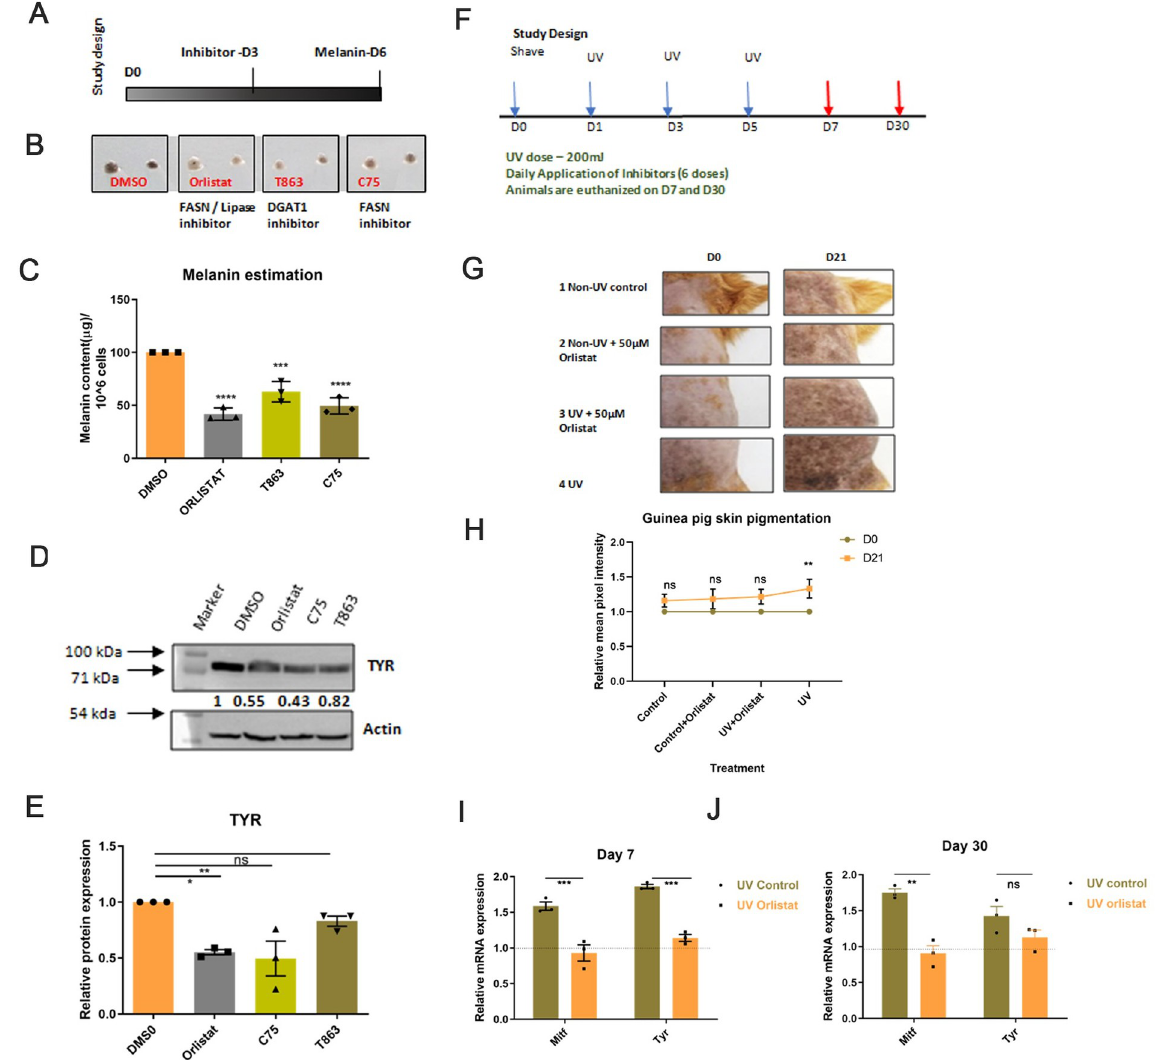
Fig 7. Fatty acid metabolism is a critical pathway in mediating pigment production. (A) Schematic showing experimental timeline for inhibitor addition and analysis of pigmentation in B16 cells. ( B) Representative image showing phenotypic differences in melanin accumulation upon inhibitors treatment in 2 technical replicates of D6 cells. Two technical replicates are taken for 3 independent biological sets. ( C) Bar graph depicting melanin estimation after different inhibitor treatments. Mean ± SEM is plotted for 3 biological replicates. One-way ANOVA is applied, F(3,8) = 43.13. p -Value < 0.0001. Dunnett’s test for pairwise. ( D) Representative western blot for TYR expression, wrt to Actin, on D6 upon Orlistat, C75 and T863 treatment. Numerical values show average fold change for 3 biological replicates. ( E) Bar graph depicting quantitative analysis of tyrosinase expression upon Orlistat, C75, and T863 treatment with respect to Actin. Fold change is calculated relative to DMSO. Mean ± SEM is plotted for 3 independent replicates. One-way ANOVA is applied, F(3,8) = 8.438, p -value = 0.0074.Dunnett’s multiple comparison test is performed for pairwise analysis. ��� p -Value < 0.005, �� p -value < 0.01, � p -value < 0.05. ns is not significant. ( F) Experimental timeline showing UV-mediated pigmentation induction in guinea pigs. Three doses of UVA+B were given on days 1, 3, and 5 (shown by the blue arrow). Six doses of inhibitor were applied for the first 6 days. Animals were euthanized on D7and D30 (shown by the red arrow). ( G) Representative photographs showing phenotypic differences in guinea pig skin pigmentation on D0 and D21. Four segments were marked based on different treatments and are followed temporally on the same animals in the groups of 3. Arrows represent the region showing maximum changes. ( H) Line plot showing fold change of mean pixel intensity of images on D21 normalized to D0. Fold change was calculated by comparing each segment across days on the same animal. Mean ± SEM is plotted for 3 independent biological replicates. Two-way ANOVA is applied. Sidak’s multiple comparison test is performed for pairwise analysis. p -Value for Control D0–D21 = 0.1882, p -value for Control + Orlistat D0–D21 = 0.1104, p -value for UV + Orlistat D0–D21 = 0.0554, p -value for Control D0–D21 = 0.0055. ( I) Bar graph depicting qRT-PCR-based analysis of Mitf and Tyr expression from epidermal cells on day 7. Mean ± SEM is plotted for 3 individual guinea pigs. One- way ANOVA is applied, F(3,8) = 36.64, p -value < 0.0001. Tukey’s test is performed for pairwise analysis. ��� p -Value < 0.005, �� p -value < 0.01, � p -value < 0.05. ( J) Bar graph depicting qRT-PCR-based analysis of Mitf and Tyr expression from epidermal cells on day 30. Mean ± SEM is plotted for 3 individual guinea pigs. One-way ANOVA is applied, F(3,8) = 12.87, p -value = 0.002. Tukey’s test is performed for pairwise